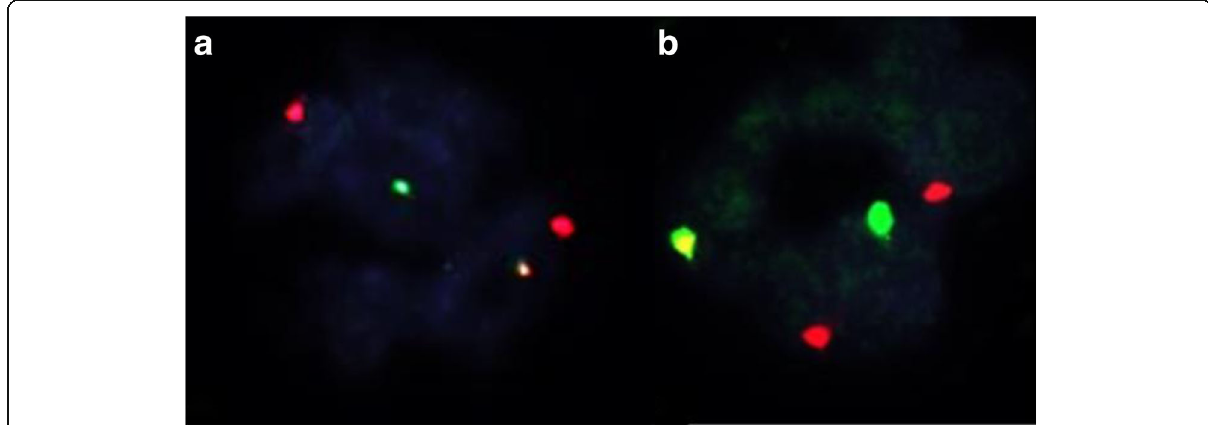
Fig. 5 Fluorescence in-situ hybridization studies demonstrating t(14;16)(q32;q23) in both mediastinal lymph node ( a ) and gingival biopsy ( b ). The abnormal signaling patterns are 2R1G1F ( a ) and 2R1G1F ( b ) by dual color, dual fusion